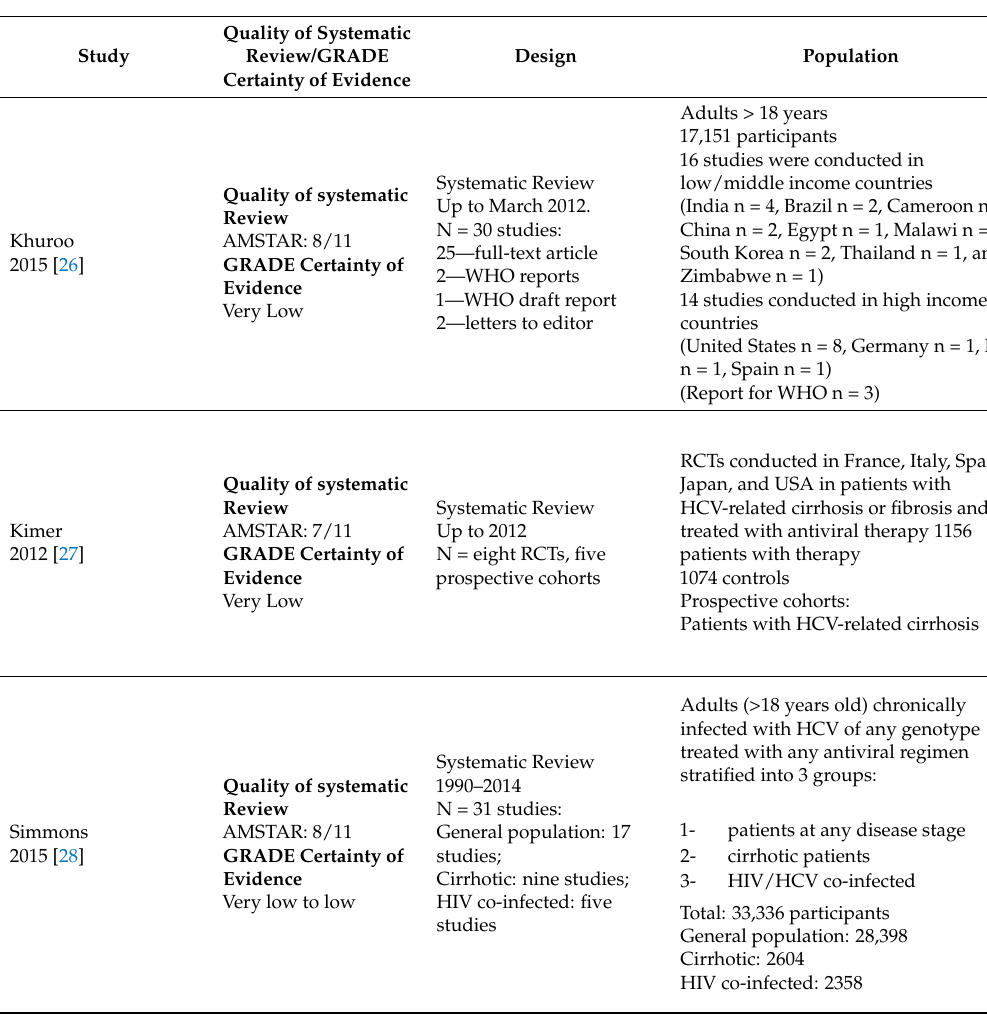
Table 1. Characteristics of studies on the effectiveness of hepatitis C